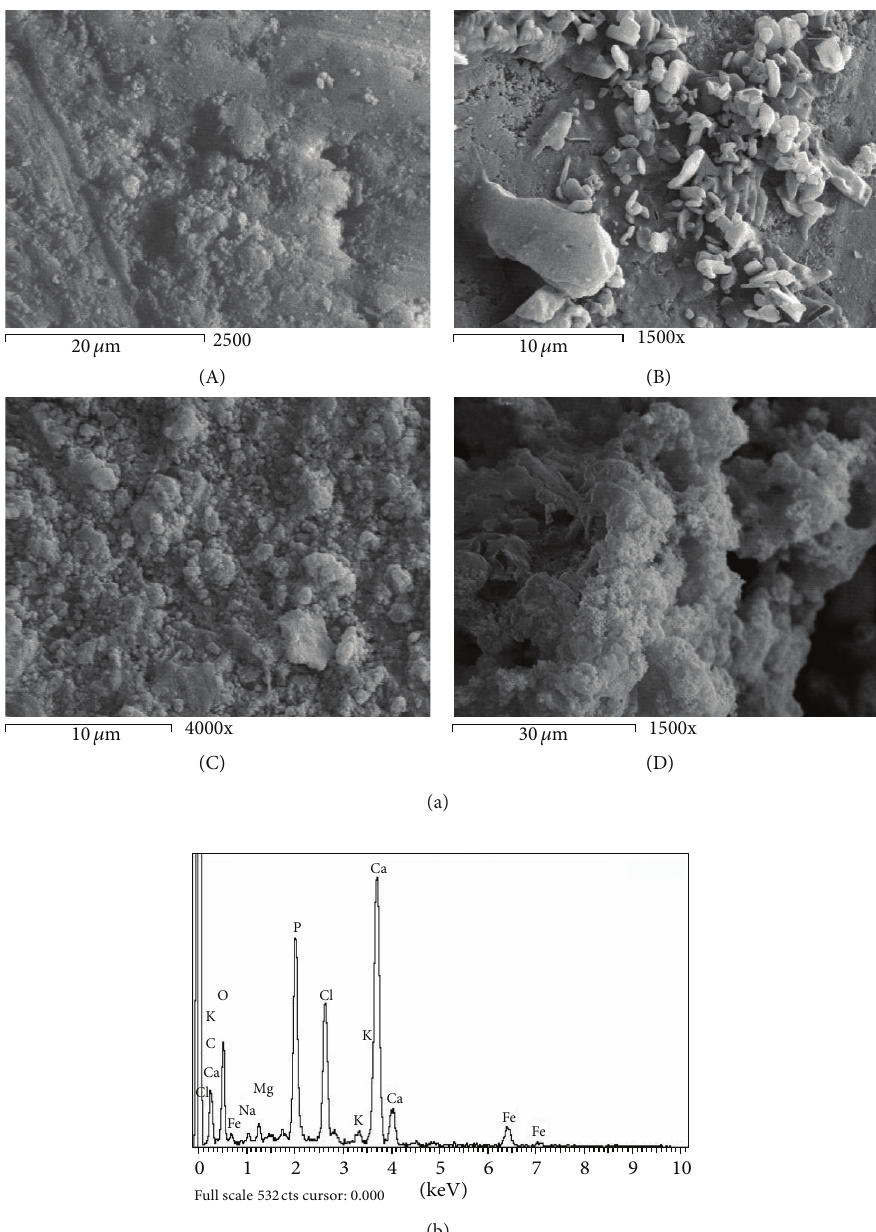
Figure 6: (a) SEM micrograph of Ce-doped glass ceramics (A) before, (B) after 1 week, (C) after 2 weeks, and (D) after 4 weeks of immersion in SBF. (b) EDAX of Ce-doped glass ceramics after 4-week immersion in